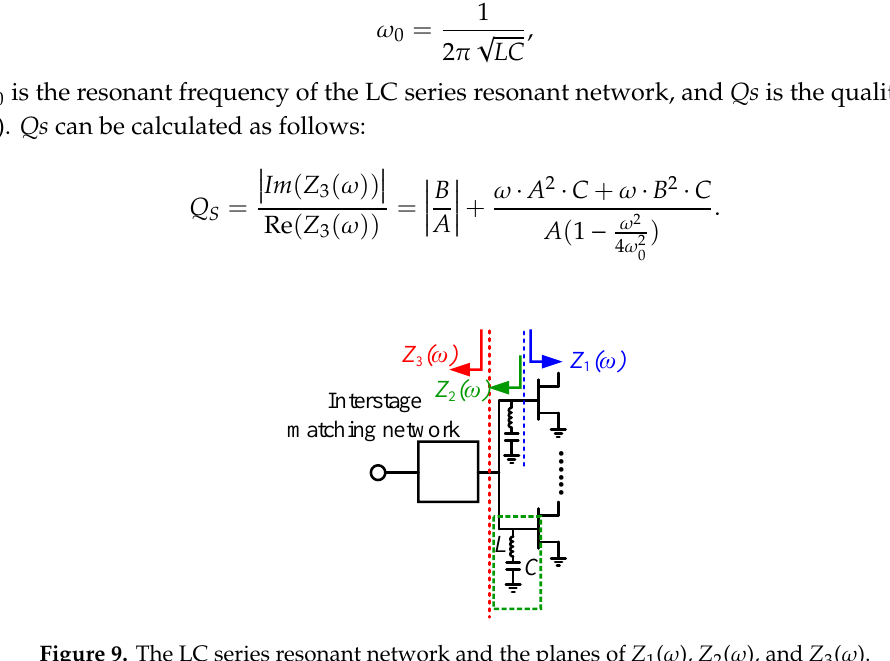
Figure 9. The LC series resonant network and the planes of Z 1 ( ω ), Z 2 ( ω ), and Z 3 ( ω